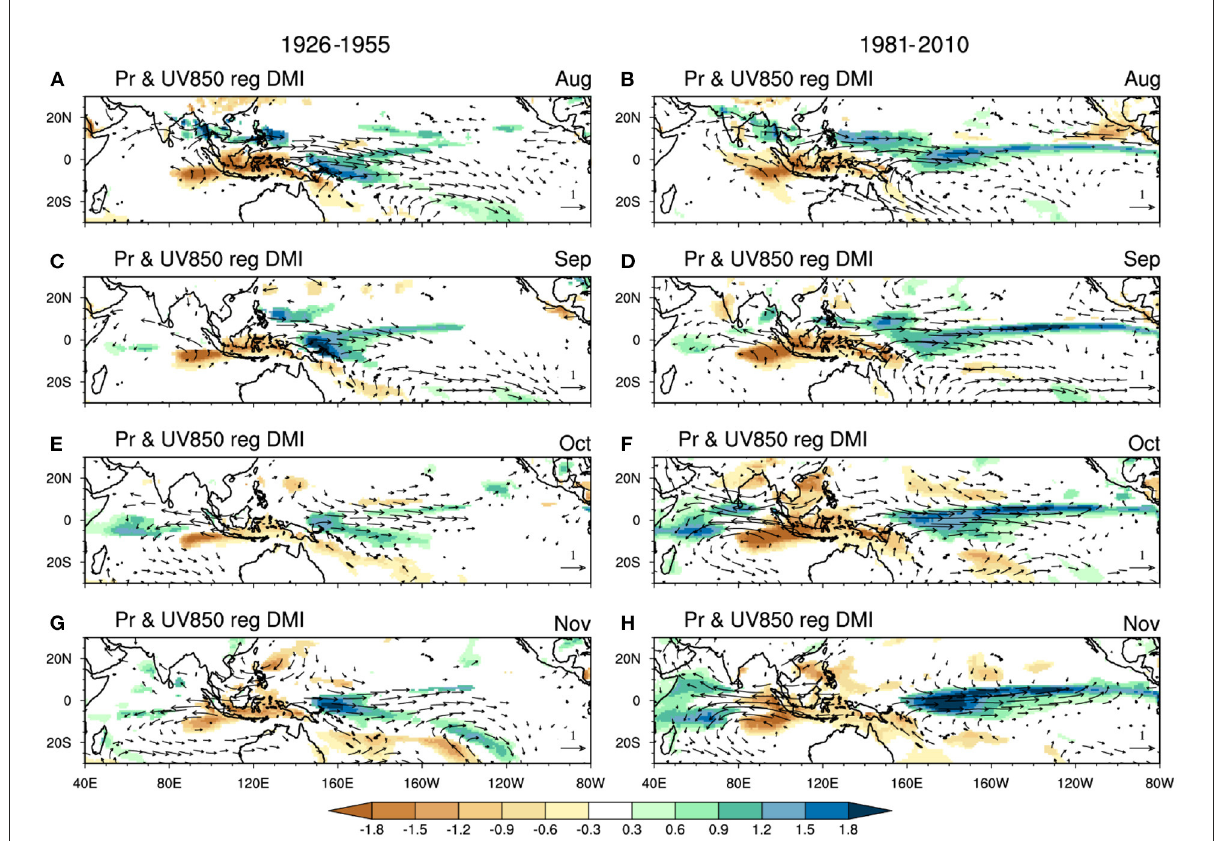
FIGURE3 As in Figure 2, but for the regression of monthly precipitation (shading, unit: mm/day) and 850-hPa wind anomalies (vector, unit: m/s) for the period (A, C, E, G) 1926–1955, and (B, D, F, H) 1981–2010.